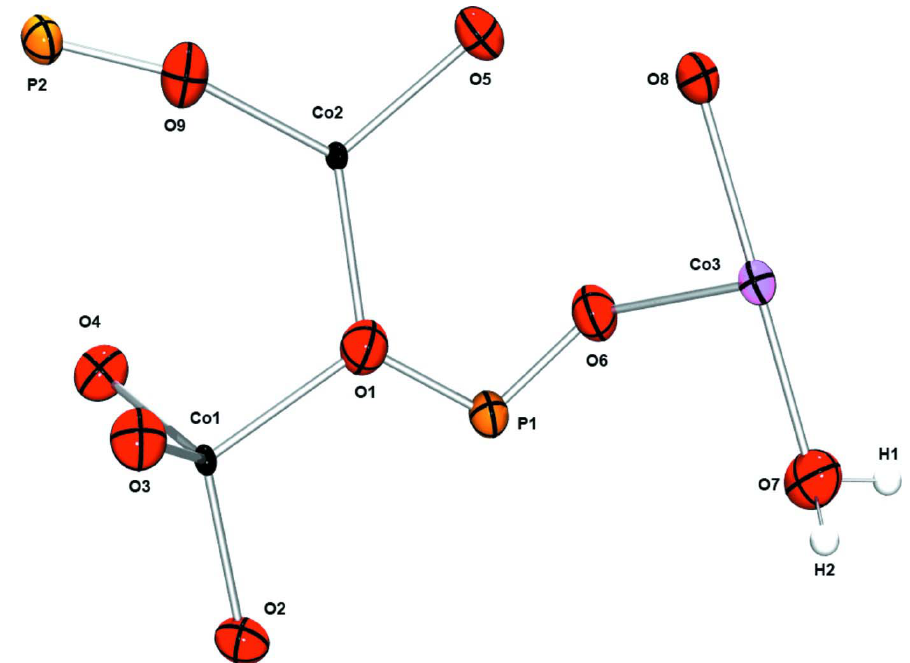
Figure 1 The asymmetric unit of compound (I), drawn with displacement parameters at the 50% probability level. H atoms are given as spheres of arbitrary radius.